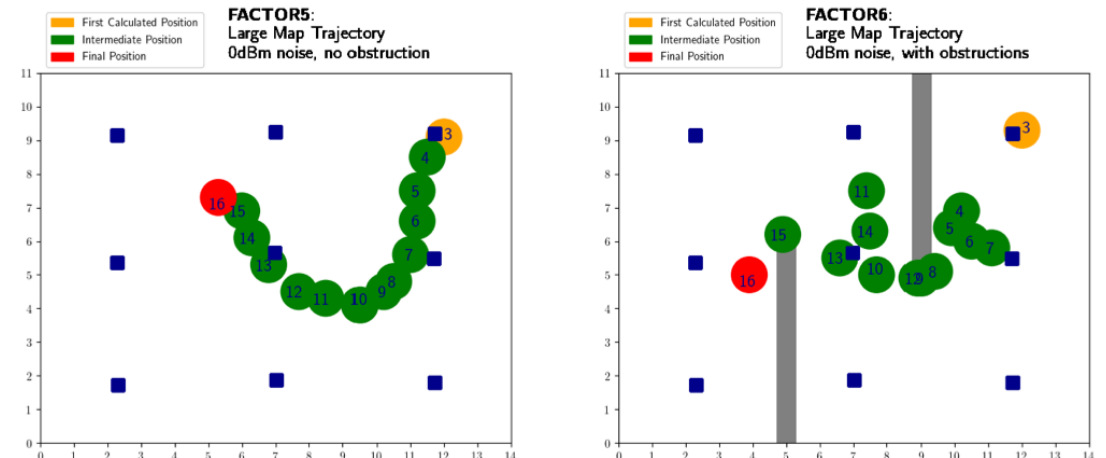
Figure 4. The OASLTool displays the trajectory, obstructions and placement of the receivers in the environment. Blue squares show the placement of receivers; the orange circle is the first predicted position of the tag; green circles with numbers show the intermediate time-steps; the red circle marks the end of trajectory. Gray blocks represent the concrete obstructions in the environment, such as walls. The axes show the dimensions of the environment in meters.